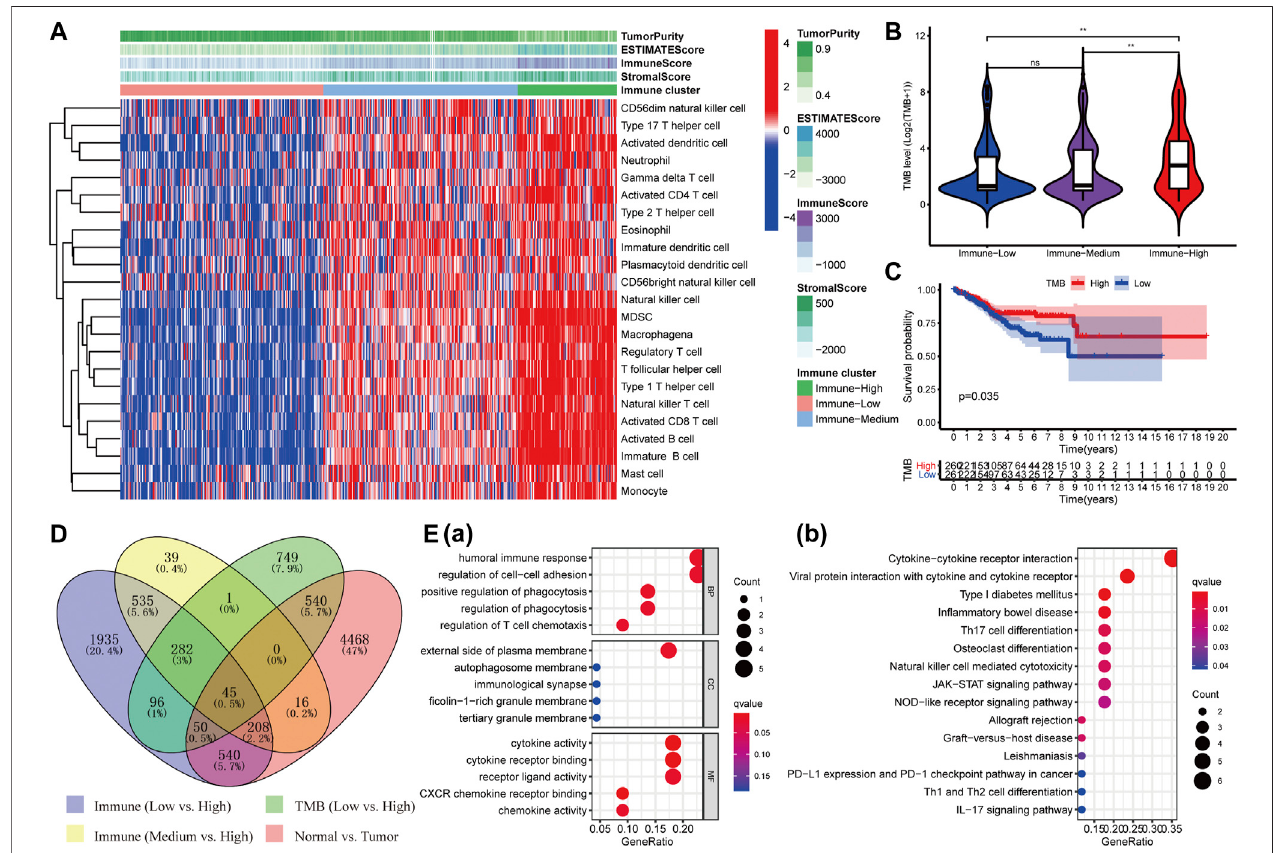
FIGURE 1 | Identi fi cation of DEIGs and enrichment analysis. (A) Three clusters with distinct immune components (Immune High, Immune Medium, and Immune Low) wereobtainedbasedon23typesofimmunecells.ThedifferenceofTMBlevelamongthethreeimmuneclusters (B) anditssurvivalcurveinUCECpatients (C) . (D) Forty- fi ve shared DEIGs were identi fi ed according to the four comparison groups as shown in the fi gure. (E) GO (a) and KEGG (b) analysis of those DEIGs.